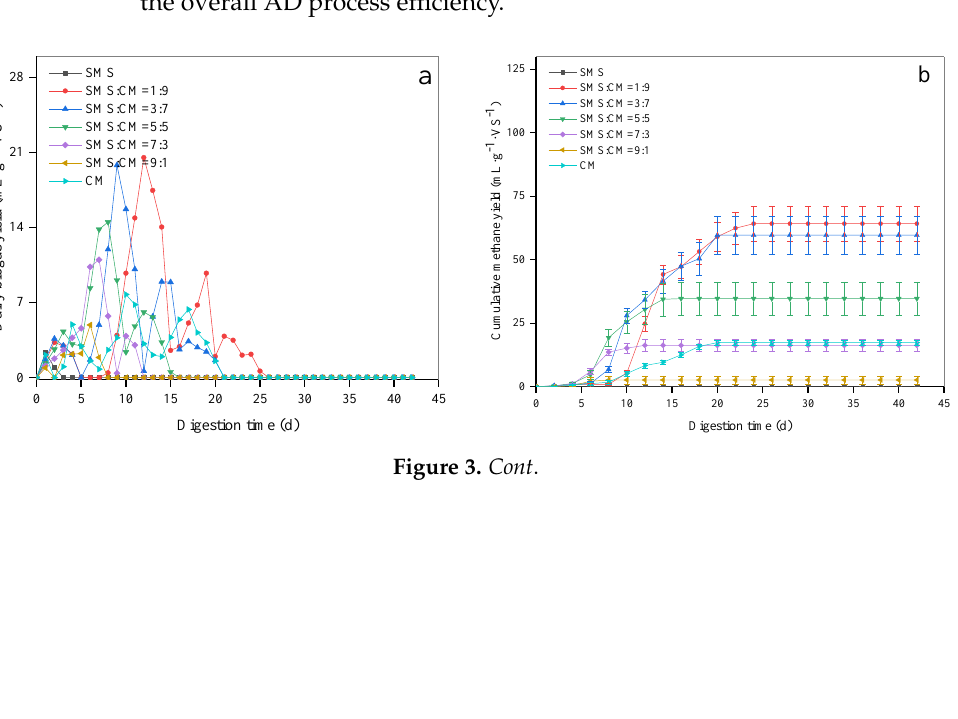
Figure 2. The cumulative methane production ( a ) and the maximum methane content ( b ) of co-digestion of SMS and different livestock manure.